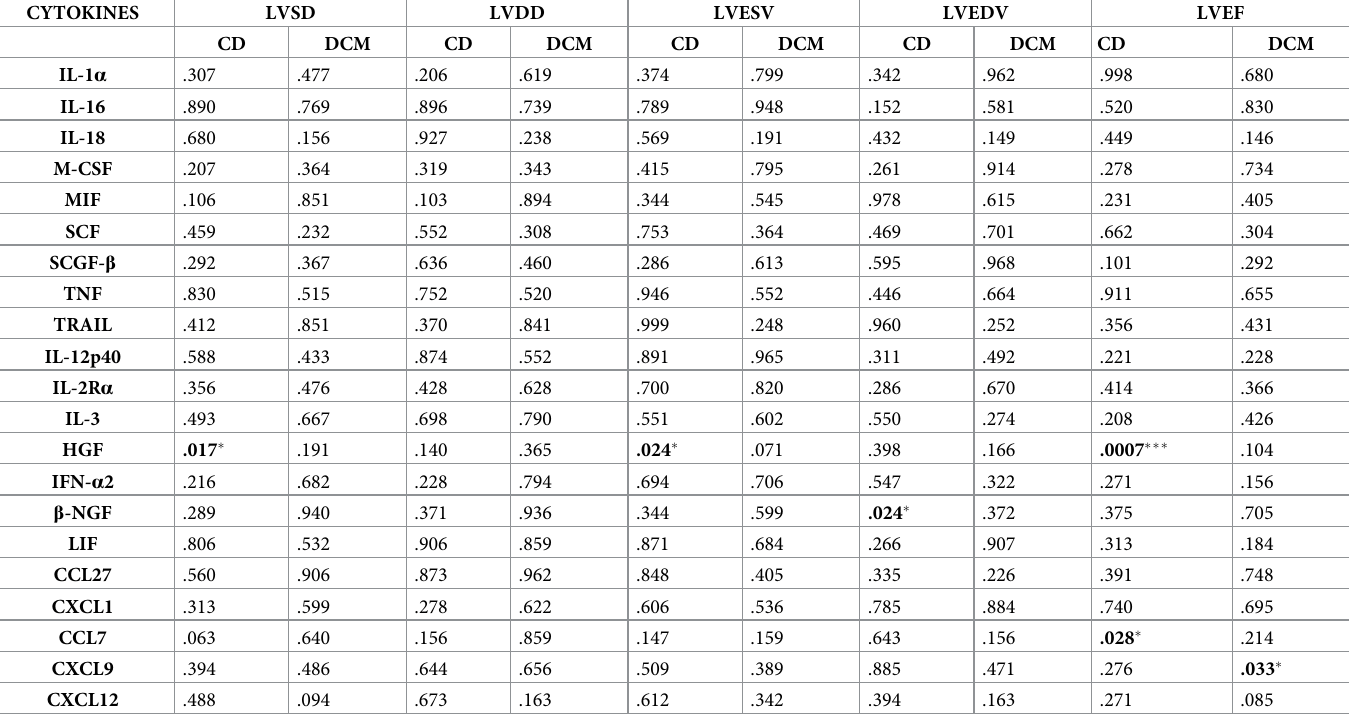
Table 3. Correlation of 21 different cytokines with echocardiographic parameters in CD (NYHA I-IV) and DCM (NYHA I-IV) patients. CYTOKINES LVSD LVDD CD IL-1 α IL-16 IL-18 .680